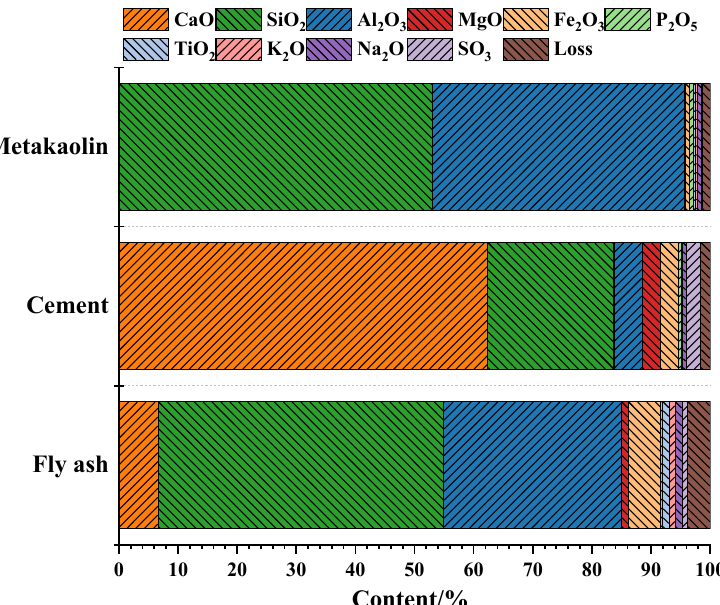
Figure 1. Chemical composition analysis of raw materials.